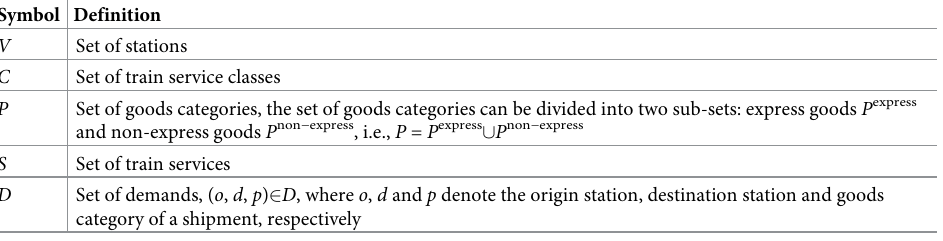
Table 1. Sets used in this paper.